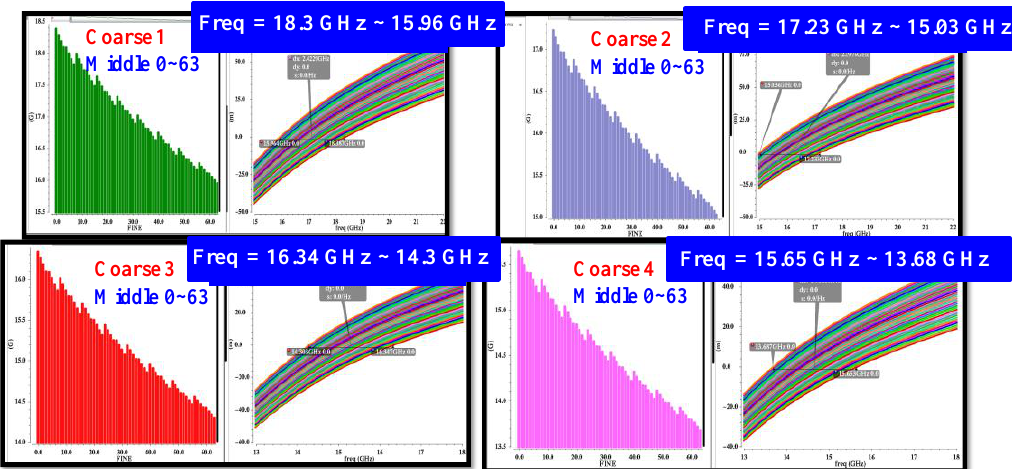
Figure 9. Linearity of the discrete tuning of VCO by coarse and middle capacitor banks. Figure 10 indicates the continuous tuning of the VCO through controlling the voltage of VC. As the simulation results show, the VCO gain is 120 MHz/V, 180 MHz/V and 300 MHz/V, at 14 GHz, 16 GHz and 18 GHz, respectively.